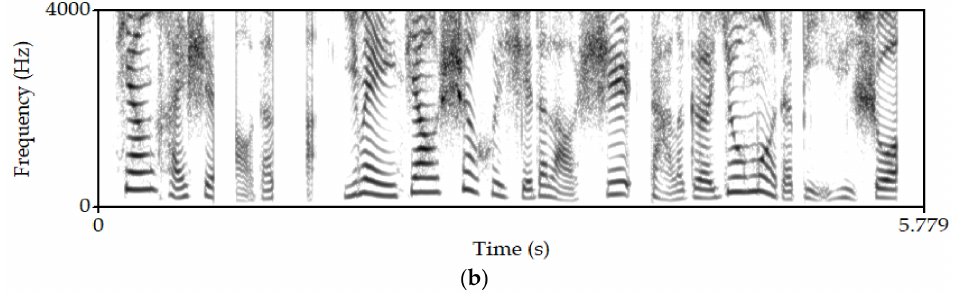
Figure 10. Damaged speech signal, different parts of the signal are tampered separately ( a ) Waveform ( b ) Spectrogram.